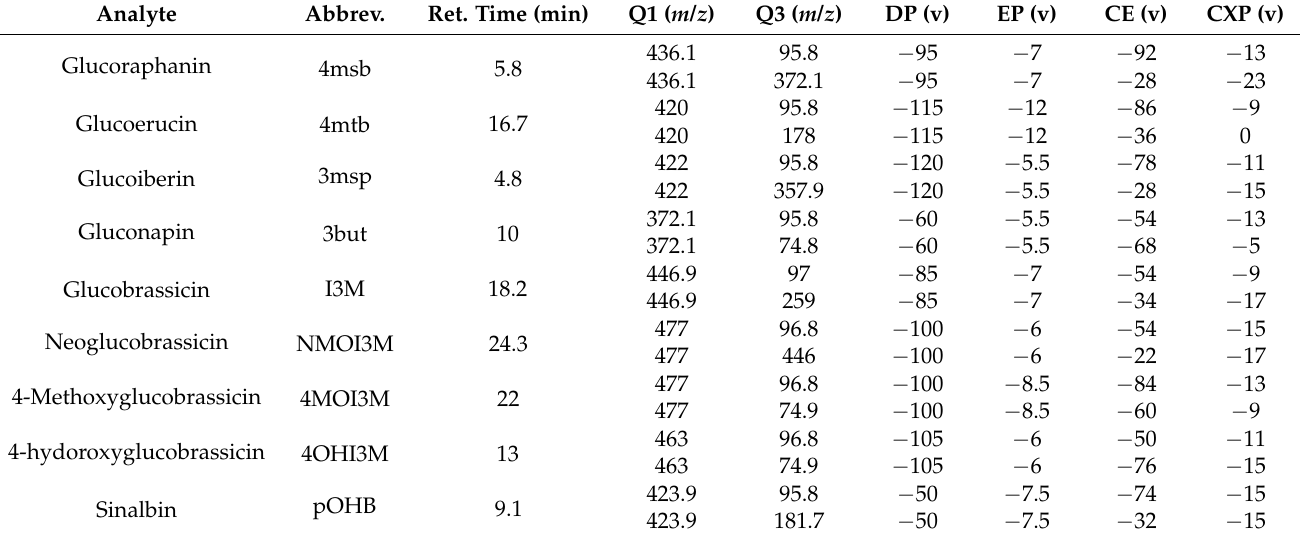
Table 5. A complete list of all multiple reaction monitoring (MRM) transitions and compound-dependent parameters for liquid chromatography-electrospray ionization-mass spectrometry (LC-ESI-MS) of intact glucosinolates in negative- mode together with retention times for reference analytes and internal standard (Sinalbin). Retention time (Ret. Time), deprotonated molecule (Q1), product ion (Q3), declustering potential (DP), entrance potential (EP), collision energy (CE), collision cell exit potential (CXP). Each analyte has two MRM